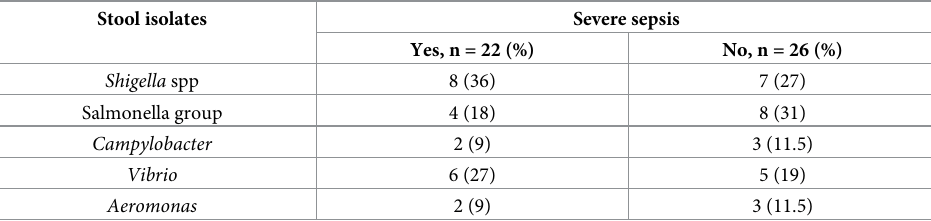
Table 4. Bacterial isolates from the stool of the study